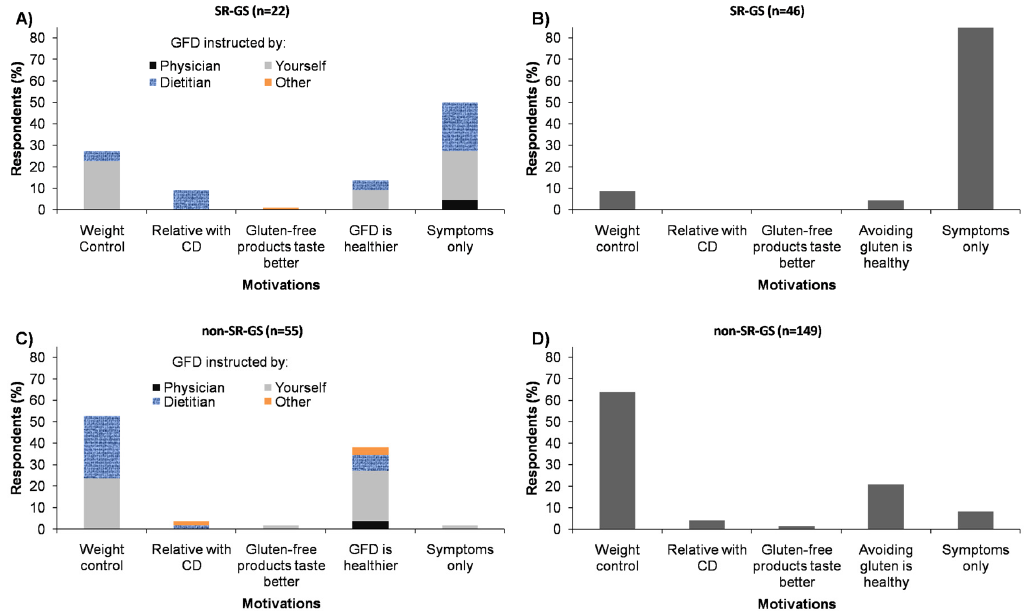
Figure 4. Motivations for following a GFD or avoiding wheat/gluten ‐ containing foods and who